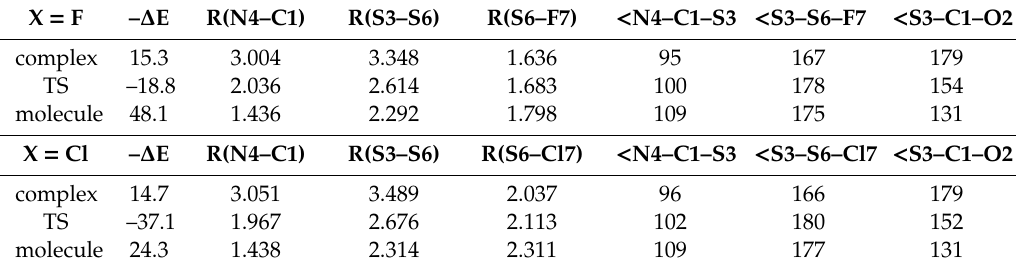
and S–C–O angles ( < , o ) for the HN(CH)SF:SCO and HN(CH)SCl:SCO complexes, transition structures, Table 5. Binding energies ( –ΔE, kJ·mol – 1 ), N – C, S – S, and S – A distances (R, Å ), and N – C – S, S – S – A, and